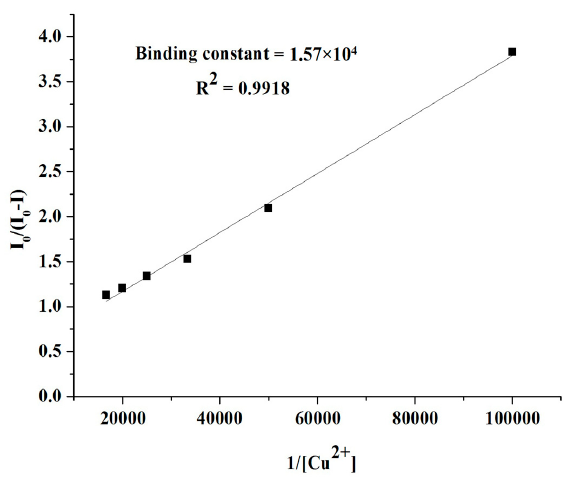
Figure 4. Stern-Volmer plot for calculating the binding constant of the chemosensor with Cu 2+ .